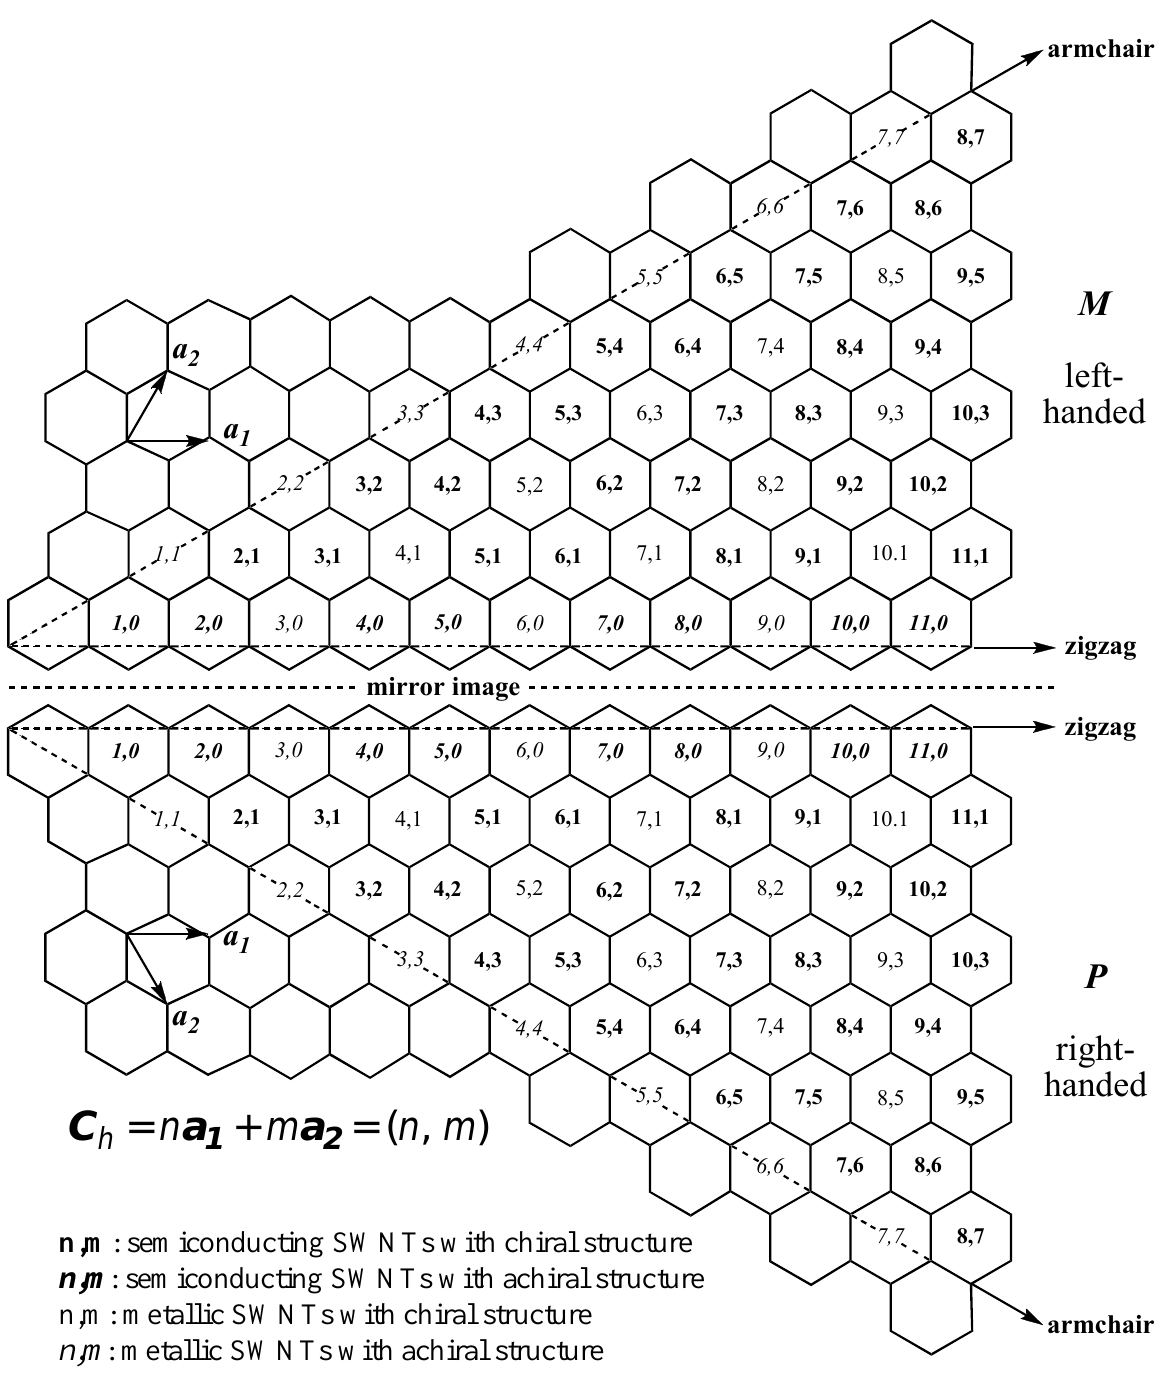
Figure 2. ( M )- or ( P )-( n , m )-SWNT defined by rolling up the graphene along the roll-up vector C from the front to the back, so that the front and back sides become the outer and h inner surfaces of the SWNT,